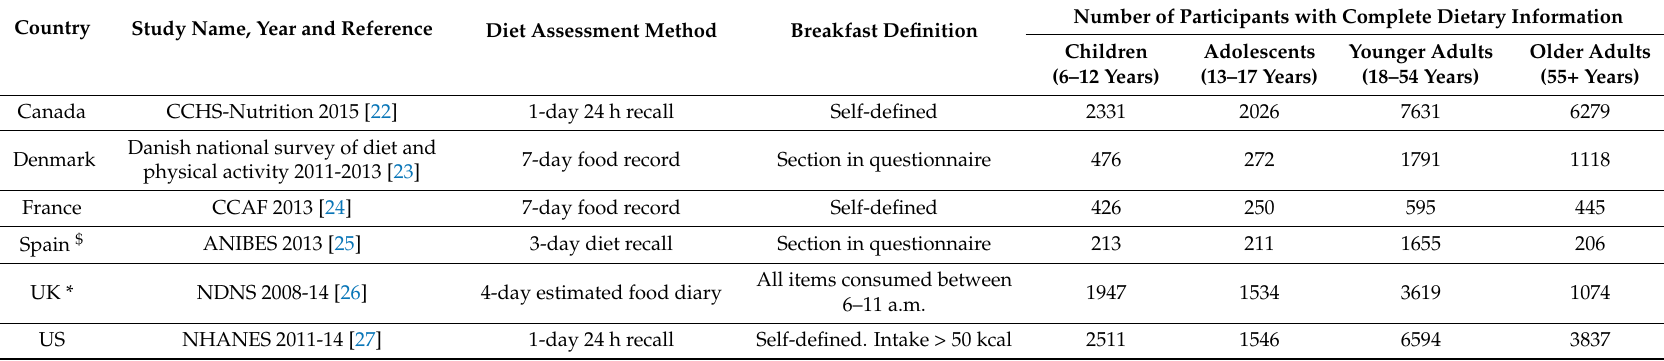
Table 1. Dietary intake surveys used in the International Breakfast Research Initiative (IBRI), and associated definition of breakfast in the